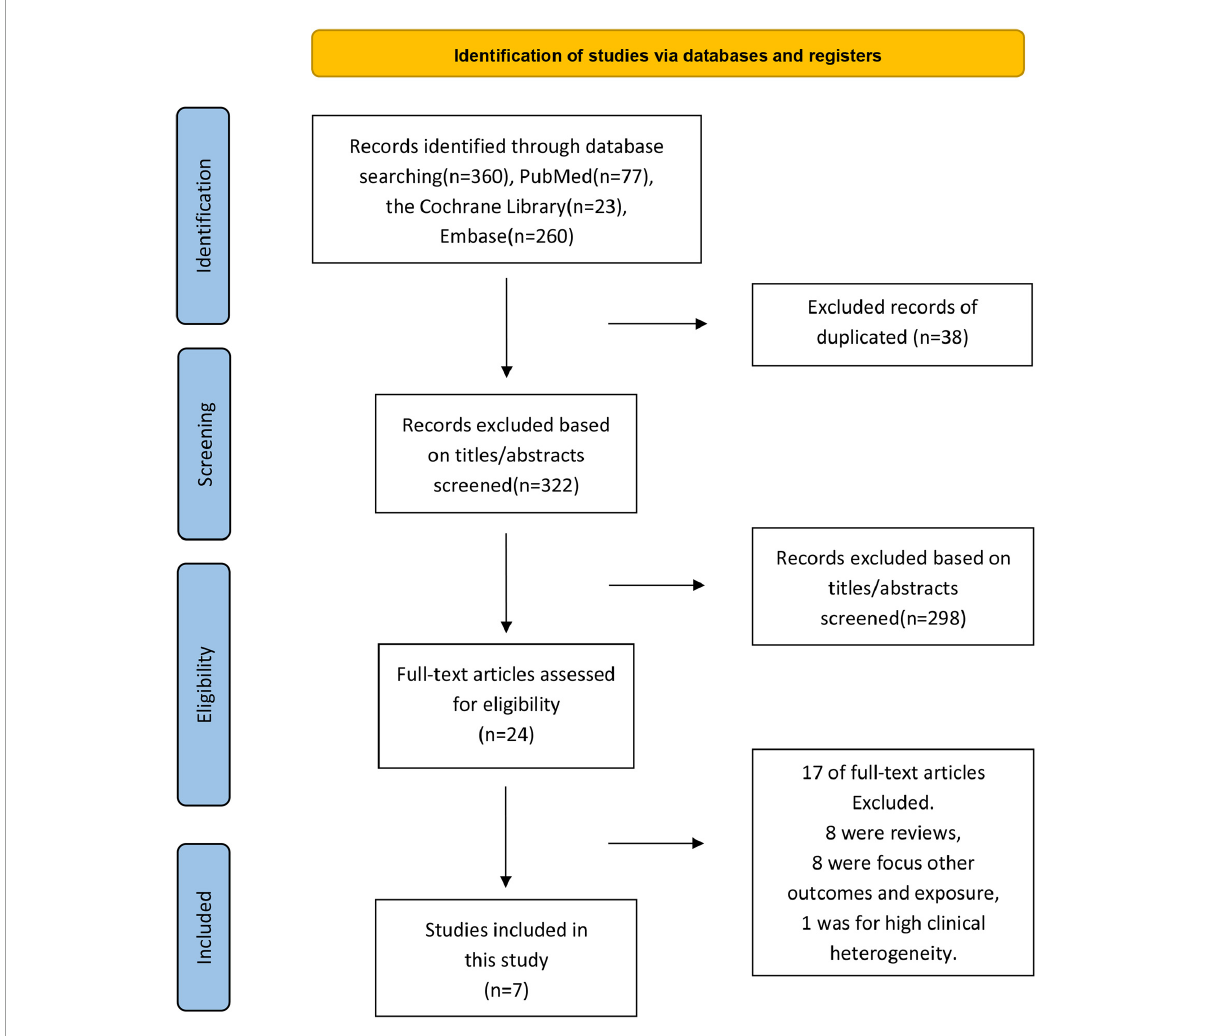
FIGURE1 Flowchart of included and excluded studies in the meta-analysis of the association between influenza vaccination and the risk of